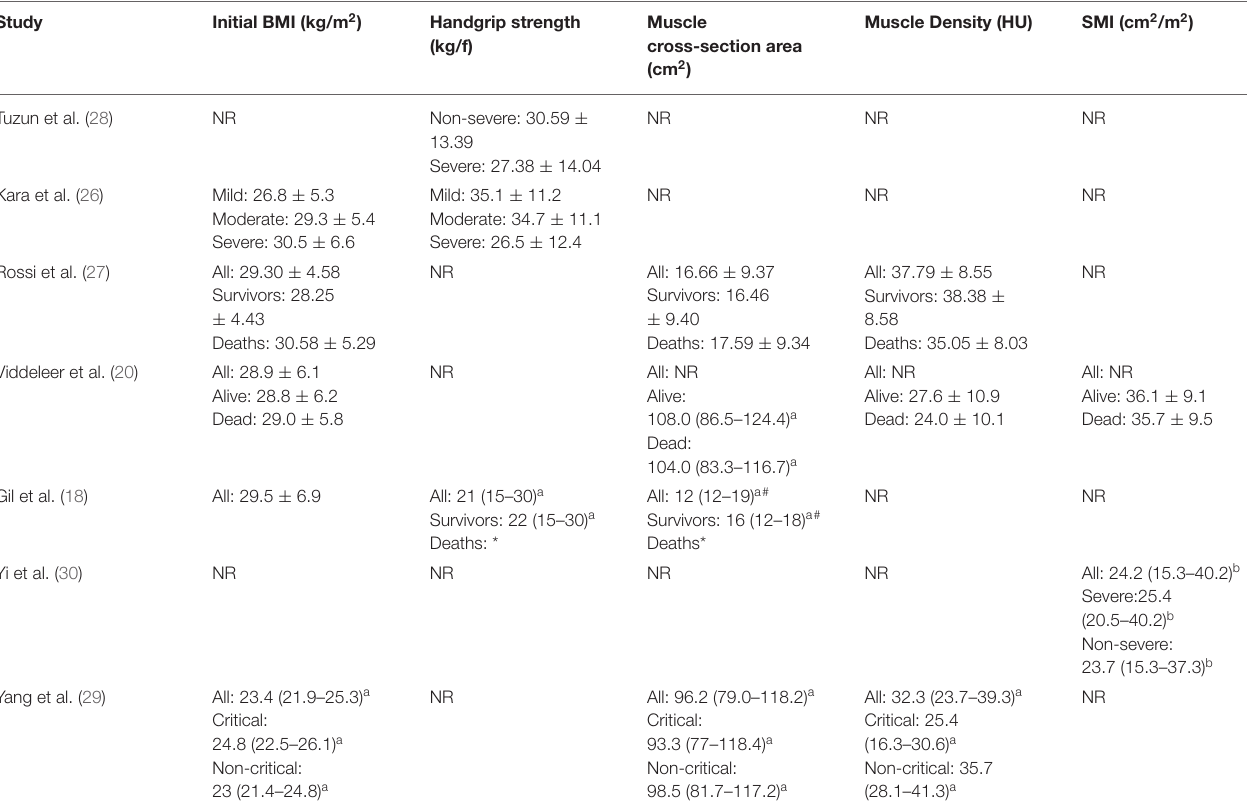
TABLE 3 | Baseline patient’s data from all included studies in this meta-analysis.